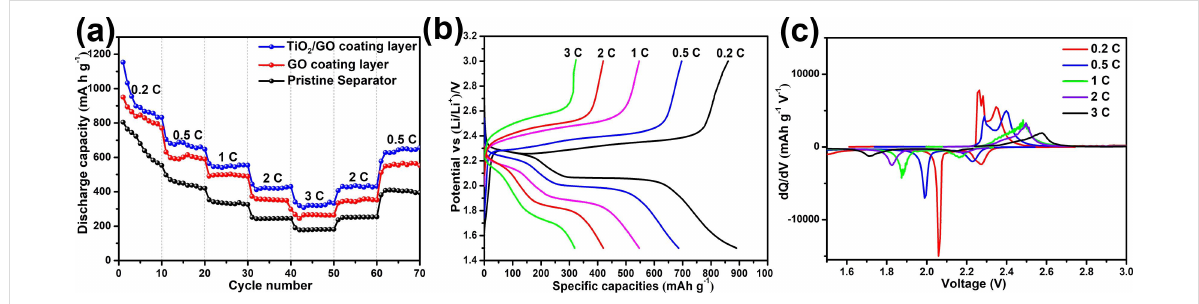
Figure 7: (a) Rate capability of the Li/S batteries with pristine, GO-coated and TiO 2 /GO-coated separators. (b) Charge/discharge curves and (c) cor- responding d Q /d V curves of the Li/S batteries with a TiO 2 /GO-coated separator at different c-rates.